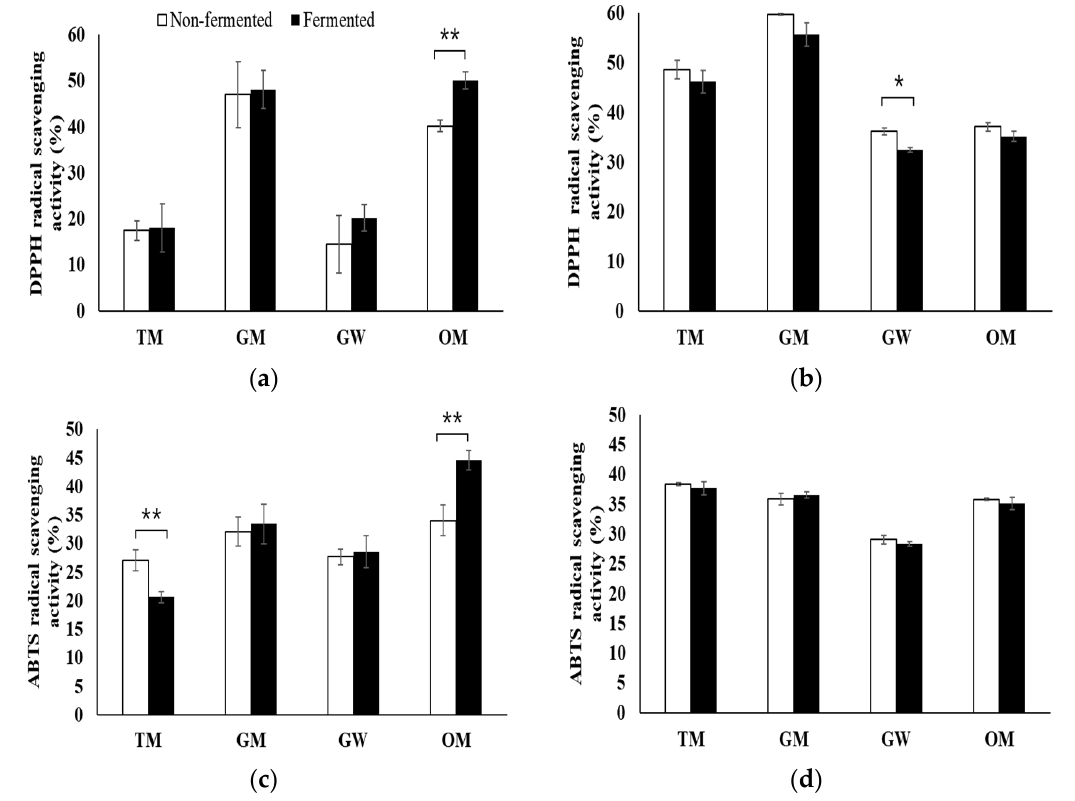
Figure 3. DPPH radical scavenging activity and ABTS of HWE and EE after fermentation for 5% ( w/v ) turmeric, ganghwa mugwort, glasswort, and omija. * p < 0.05, ** p < 0.01; ( a ) DPPH ‐ HWE; ( b ) DPPH ‐ EE; ( c ) ABTS ‐ HWE; ( d ) ABTS ‐ EE; TM: turmeric; GM: ganghwa mugwort; GW: glasswort; OM, omija.